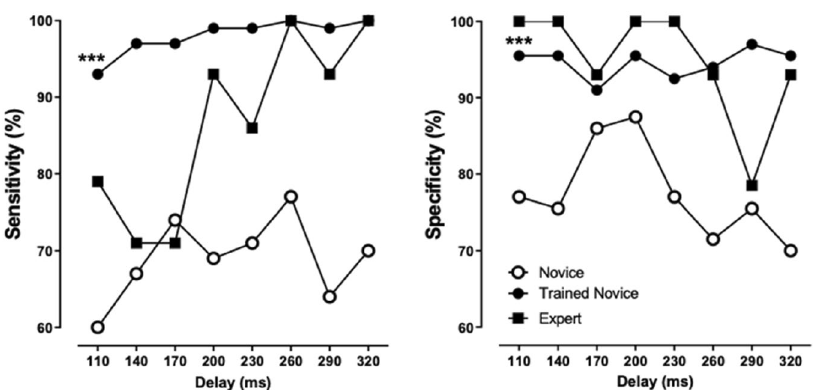
Figure 2. Sensitivity and specificity as a function of saccade delay. ***p < 0.001 for novices before versus after training at all delays (n = 70 for each delay, Fisher’s exact test), £ p < 0.05 experts versus novices after training (n = 70 for novices and n = 14 for experts, Fisher’s exact test). *p < 0.05 and ***p < 0.001 for the 110 ms delay versus delays > 230 ms in the same group (for each delay, n = 70 for novices and n = 14 for experts, Fisher’s exact test).